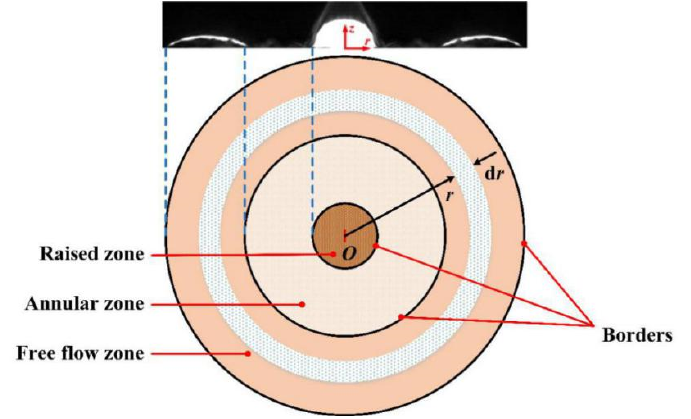
Figure 7. Divided zones of the liquid film according to radial distribution